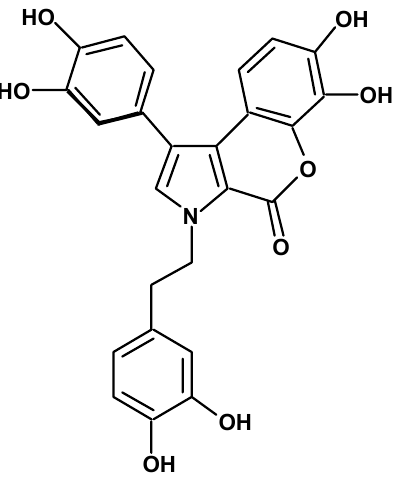
Figure 5: Structure of the marine natural product Ningalin B.